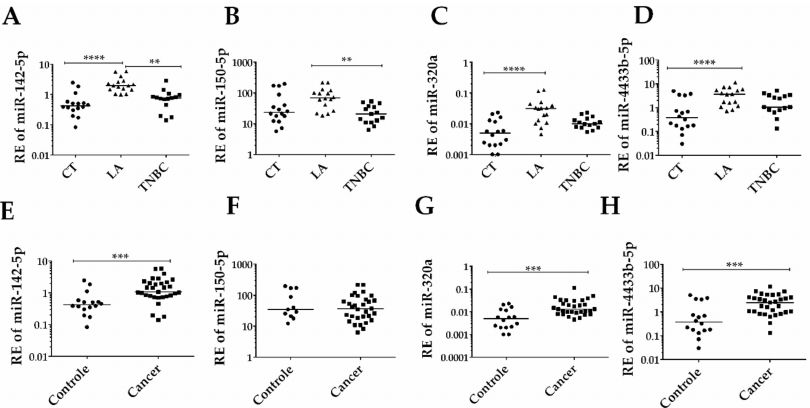
Figure 3. Expression of the selected group of EV-miRNAs according to BC diagnosis and subtypes. ( A ) Significantly increased relative expression (RE) of miR-142-5p in Luminal A (LA) patients compared to Triple-negative (TNBC) patients ( p < 0.0001), and control (CT) ( p < 0.01). ( B ) miR-150-5p RE level is significantly higher in LA compared to TNBC patients ( p < 0.01). ( C ) miR-320a and ( D ) miR-4433b-5p levels are higher in LA patients compared to CT ( p < 0.0001 for both comparisons). ( E ) Significant overexpression of miR-142-5p in cancer (LA + TNBC) patients compared to CT ( p < 0.001). ( F ) No di ff erence in miR-150-5p level between cancer and control. ( G ) Significant overexpression of miR-320a and ( H ) miR-4433b-5p in cancer patients in comparison to controls ( p < 0.001 for both). Cel-miR-39 was used as the exogenous control. BT-474 was used as a calibrator in all plates. The y-axis values are in log10, for a better presentation of the data. Analyses were calculated based on relative quantification (RQ) = 2 − ∆∆ Ct values. ** p < 0.01; *** p < 0.001; **** p <